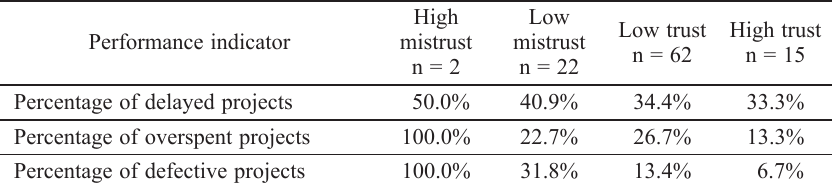
Table 2. Relationship between trust and key performance